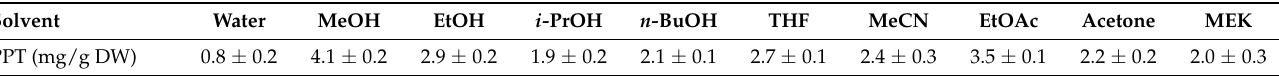
Table 1. Effect of the solvent type on the podophyllotoxin concentration relative to the weight of the starting plant material, J. virginiana leaves.